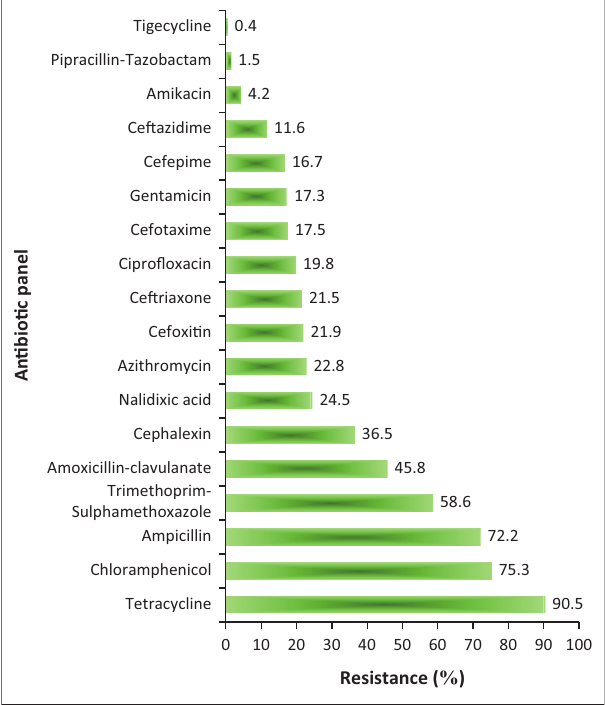
FIGURE 2: Overall antibiotic resistance in diarrheagenic E. coli pathotypes across the pig production chain.